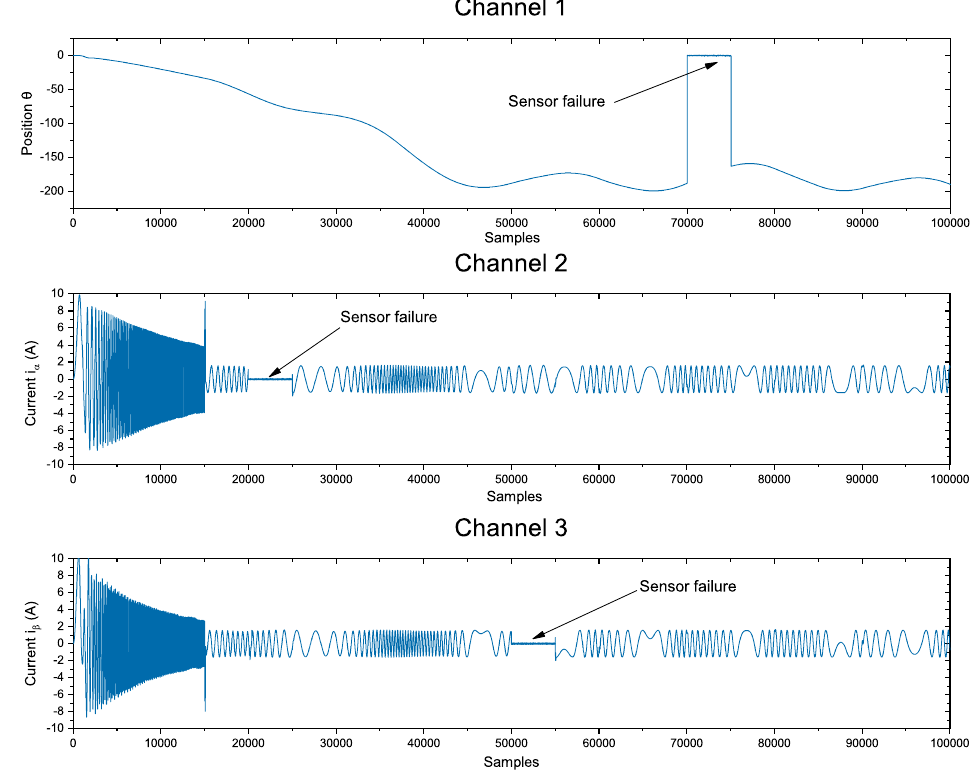
Figure 9. Sensor channel data set from the induction